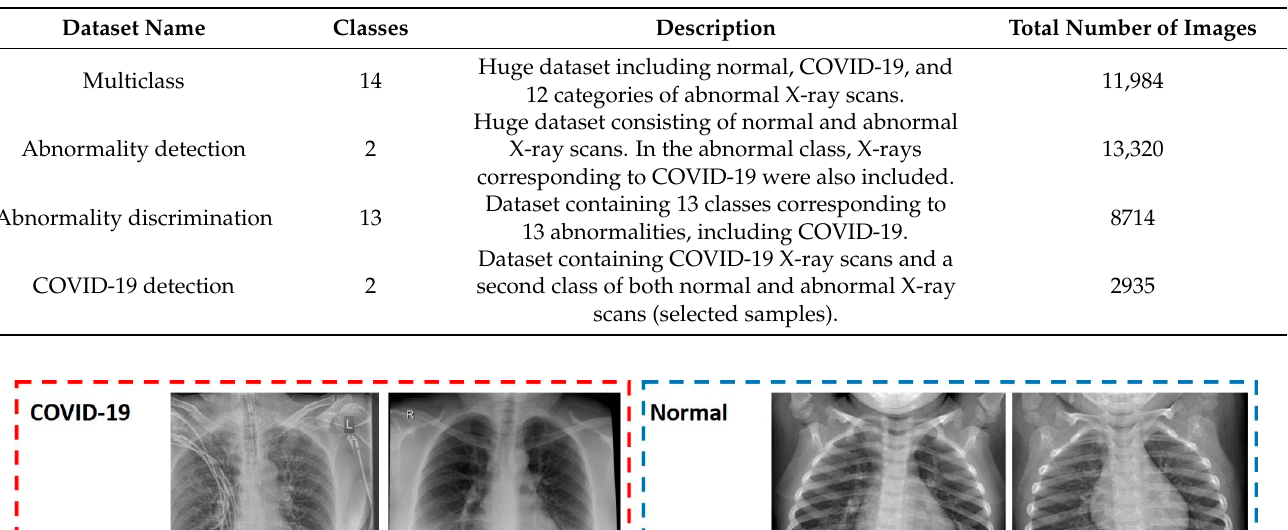
Table 1. Characteristics of the dataset.